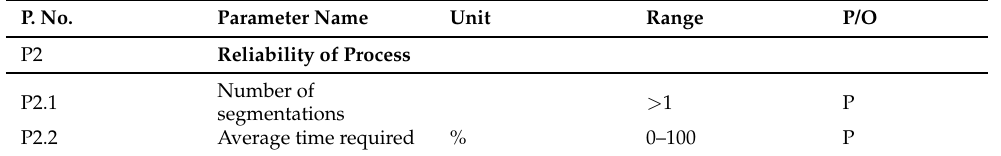
Table 6. Parameters for process reliability.